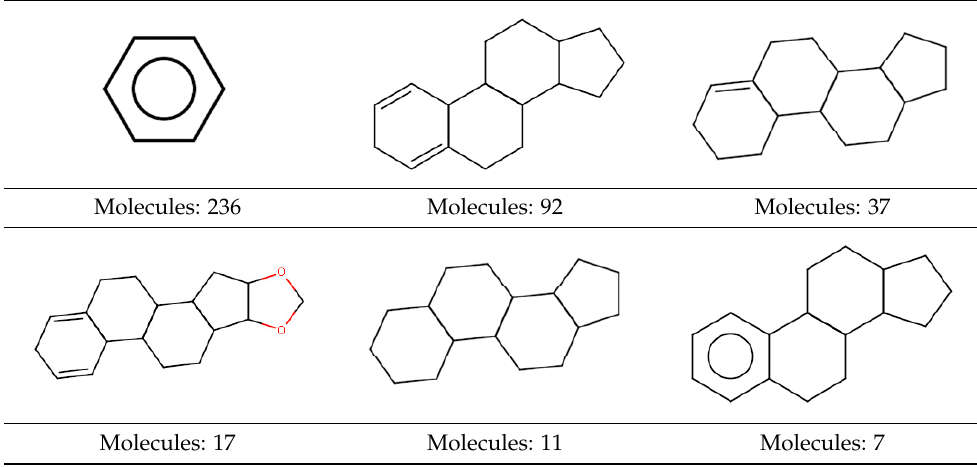
Table 6. Examples of scaffolds identified in the dataset. The most frequent scaffold is the benzene, being the scaffold of 236 molecules; additionally, 5 cyclopentaphenanthrene scaffolds are shown with the number of molecules containing them.